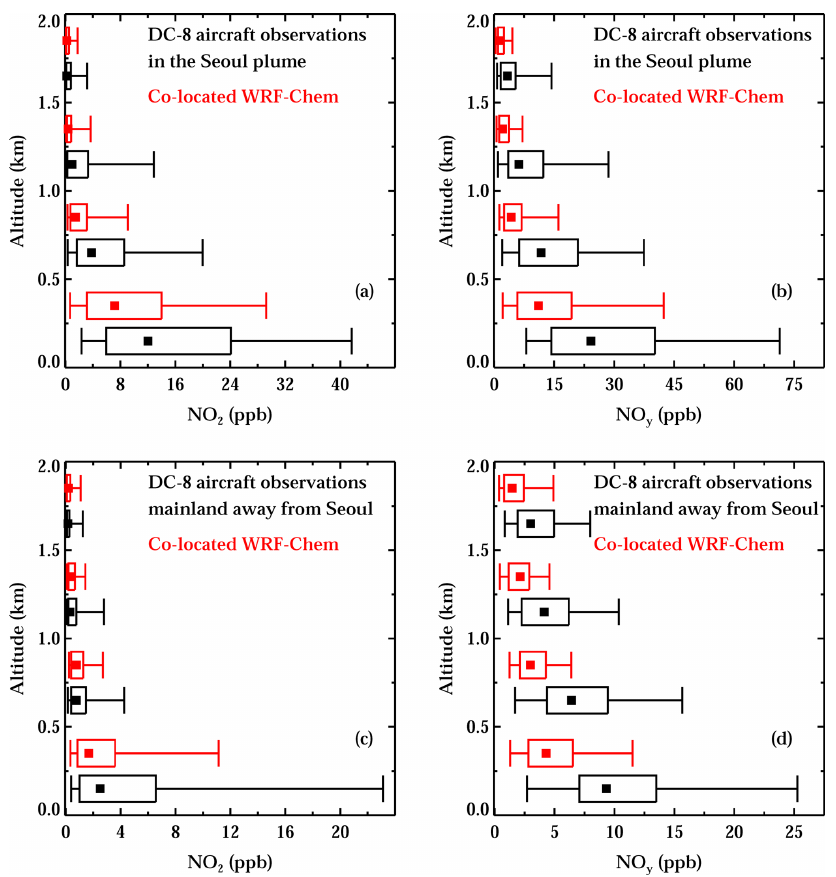
Figure 5. Measurements from the DC-8 aircraft binned by altitude in black. Co-located WRF-Chem observations within the same altitude bin as the aircraft observations are plotted above in red. Square dots represent the median values. Boxes represent the 25th and 75th percentiles, while whiskers represent the 5th and 95th percentiles. (a) Comparison of NO 2 in the Seoul plume (SW corner: 37.1 ◦ N, 127.05 ◦ E; NE corner: 37.75 ◦ N, 127.85 ◦ E), (b) comparison of NO y in the Seoul plume, (c) comparison of NO 2 in areas outside of the Seoul metropolitan area on the Korean Peninsula (SW corner: 34.0 ◦ N, 126.4 ◦ E; NE corner: 37.1 ◦ N, 130.0 ◦ E), and (d) comparison of NO y in areas outside of the Seoul metropolitan area on the Korean